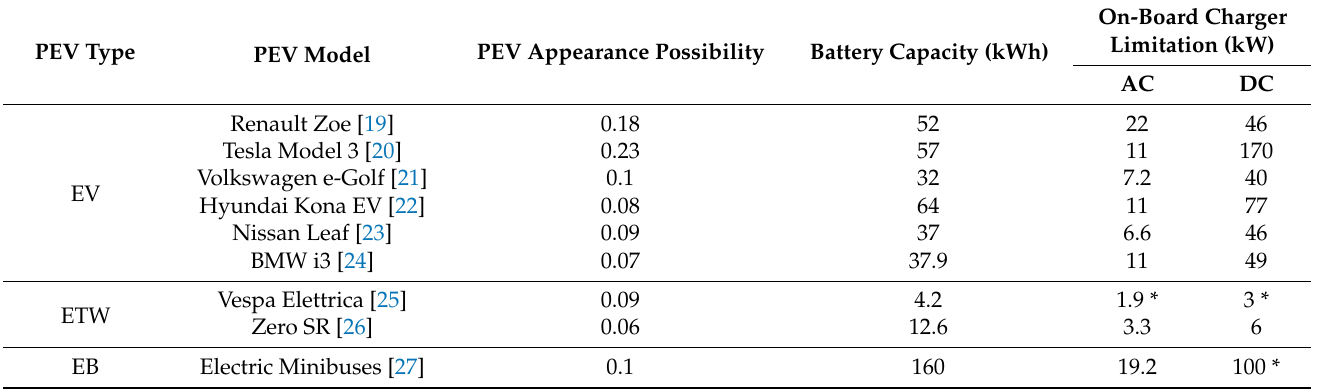
Table 1. PEV type, model, possibility appearance to the sport center, battery capacity and charg- ing